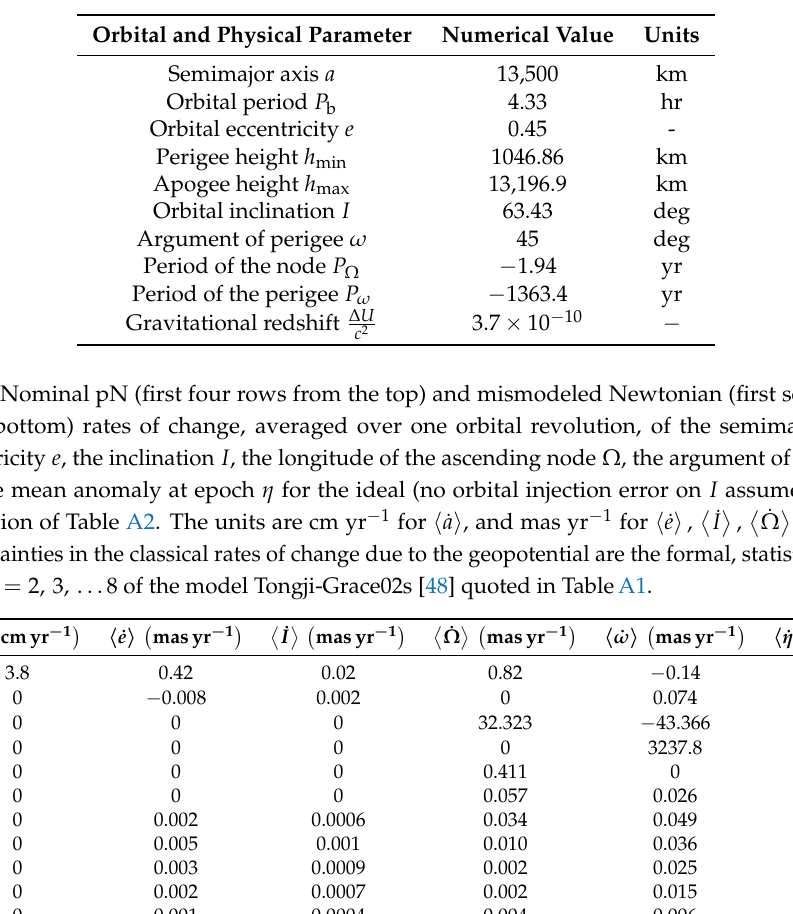
Table A2. Orbital configuration of the proposed satellite HERO: high perigee case. The orbital motion is rather fast since the orbital period P b is as short as (cid:39) 4h. The period P ω of the perigee is mainly determined by its secular precession due to J 3 , J 4 because of the critical inclination which makes the secular precession due to J 2 nominally vanishing. Note the relatively short period P Ω of the node, amounting to less than 2yr.